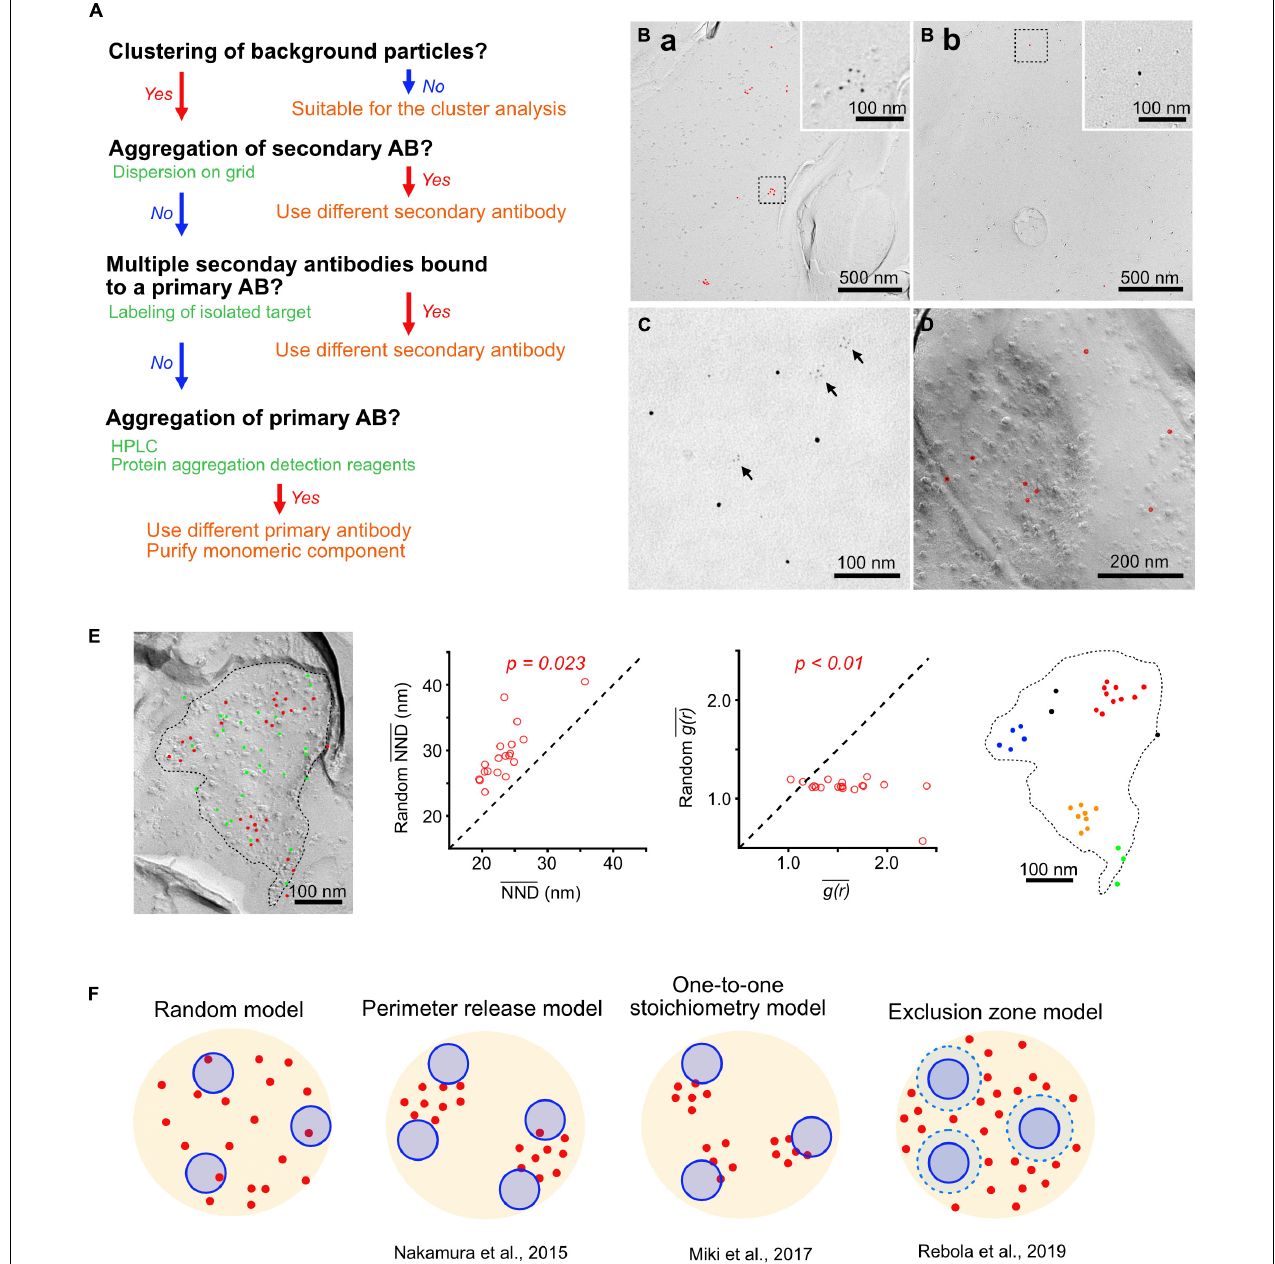
FIGURE 2 | Cluster analysis of Ca V 2 channels and the distribution models. (A) A flowchart for checking the artificial clustering of gold particles on replica samples. (B) Clustering of gold particles with two different anti-Ca V 2.1 antibodies recognizing intracellular regions of Ca V 2.1, which should give specific labeling on the protoplasmic face (P-face) of the replica. These particles represent non-specific background because they are found on the exoplasmic face (E-face) of the dendritic plasma membrane. Antibody A showed non-specific labeling with clusters of several gold particles (Ba) , whereas antibody B showed mostly isolated single background particles (Bb) . (C) Aggregation of secondary antibodies. The EM image of a mixture of goat anti-rabbit IgG conjugated with 2 nm gold particle and goat anti-guinea pig IgG conjugated with 5 nm gold particle dispersed on a grid coated with formvar. The secondary antibody with 2 nm gold particle had aggregations (arrows), whereas that with 5 nm gold particle did not. (D) Sparse distribution of gold particles labeling VGluT1 at the PF bouton of the mouse cerebellum, indicating binding of single gold particle-conjugated secondary antibody to a primary antibody. Red circles indicate the gold particles. (E) Cluster analysis of Ca V 2.1. Left , an example of Ca V 2.1 labeling at a PF-PC synapse of the mouse cerebellum. Red and green points indicate real and randomly simulated particles, respectively, in the AZ (dashed line). Middle , comparison of the mean NND ( left ) and g(r) values in each AZ obtained from the real and simulated particles. P -values were calculated by paired t -test. Right , cluster detection of the gold particles using DBSCAN with parameters of 3 for the minimum number of the particles in a cluster, and